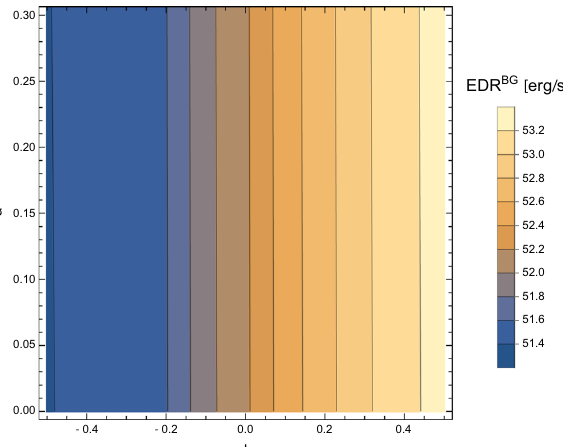
Fig. 2 Acontourplotoftheparameterspace l − a showingtheEDR BG related to BG-based slowly rotating Kerr black hole in isothermal disk model. Here the color scale written in the logarithmic form log10 n (the range of n is from values lesser than 52 to beyond